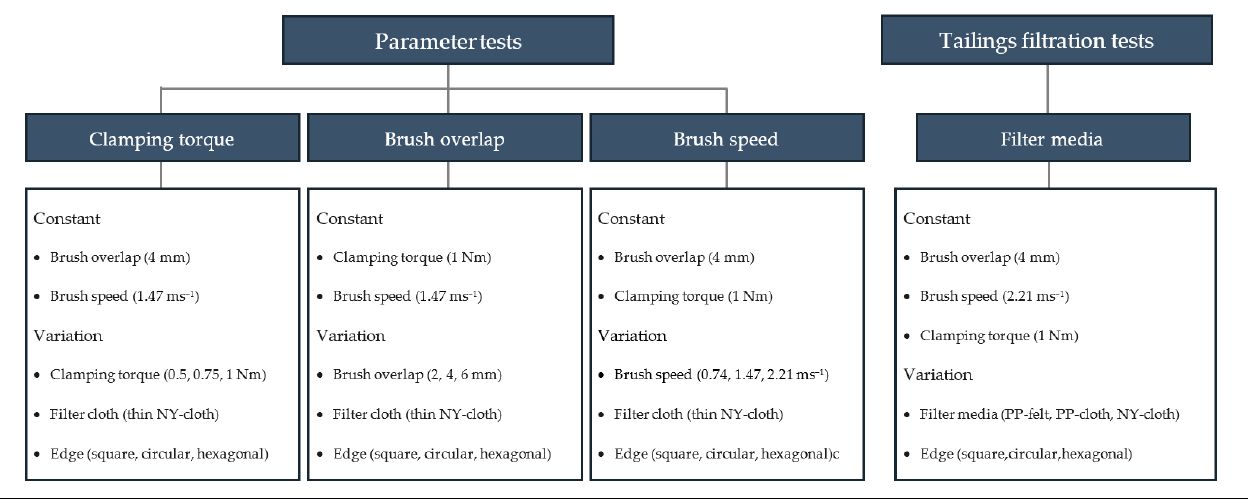
Table 1. Properties of apparatus parameter tests filter cloth.